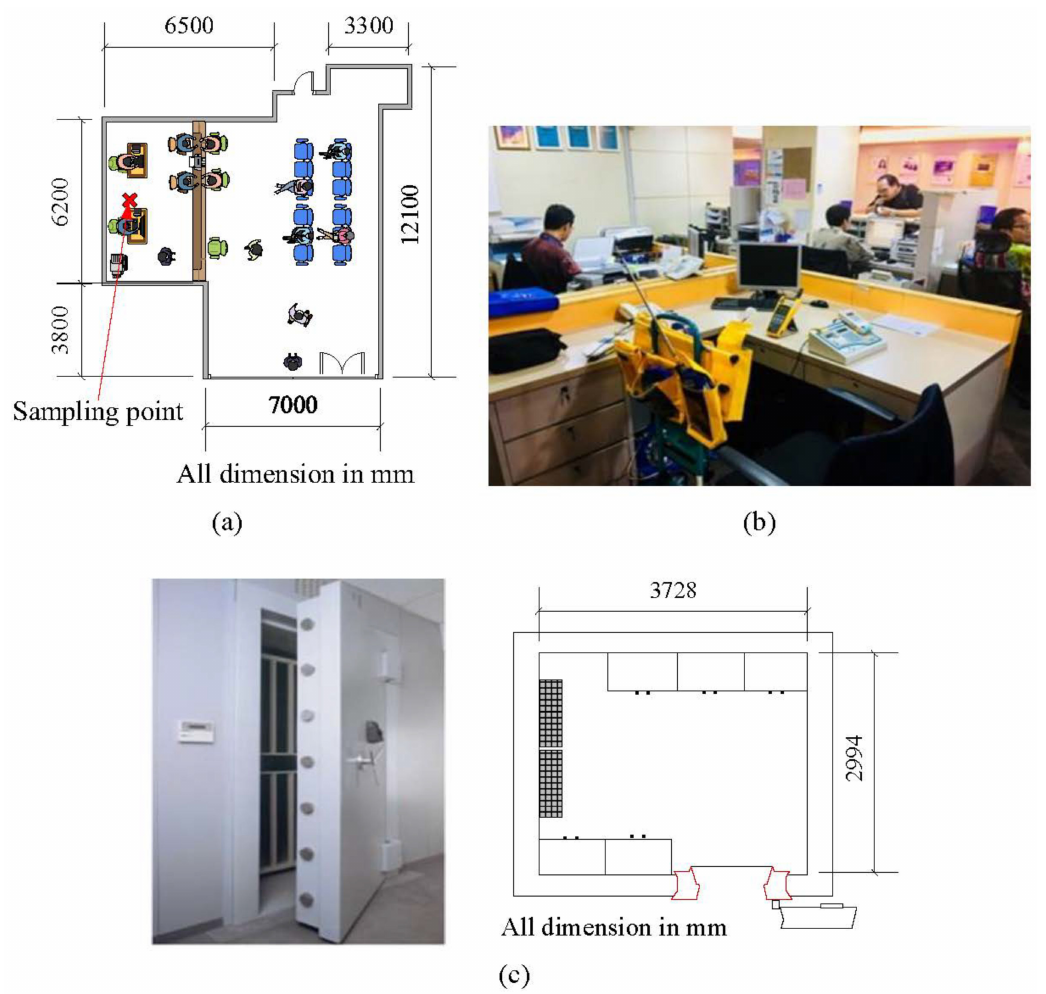
Figure 2. Location of sampling. ( a ) Floor plan bank 3 (operation division). ( b ) Photo of sampling equipment ( c ) view and floor plan bank 3